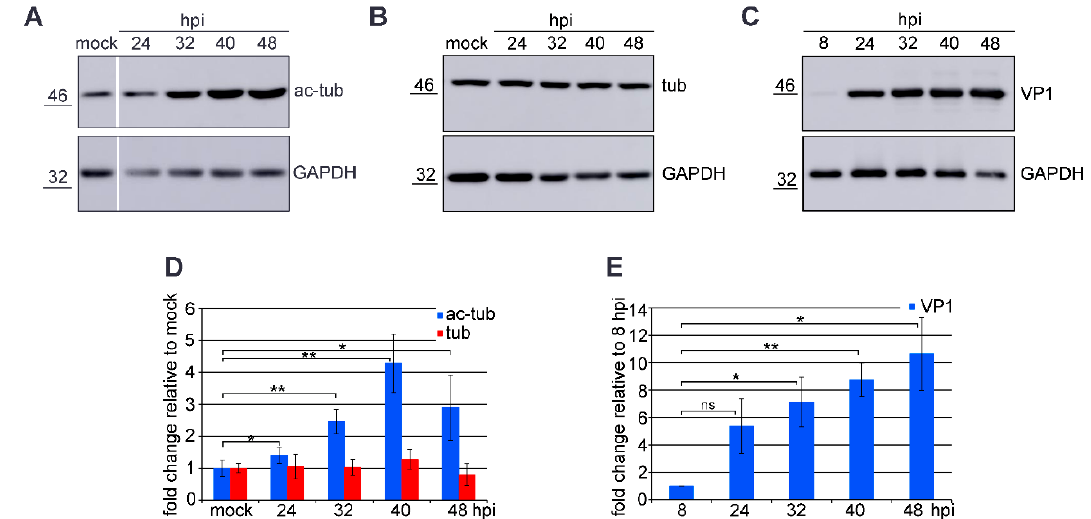
Figure 1. The acetylation of microtubules was elevated during the late phase of infection. ( A – C ) 3T6 cells were infected with MPyV and lysed at the indicated hours post infection (hpi). Lysates were separated by SDS / PAGE, transferred onto membrane, and acetylated tubulin (ac-tub), tubulin (tub), VP1, and GAPDH were stained by specific antibodies. ( D , E ) A graphic illustration of a densitometry analysis of the digital images of Western blots from four independent experiments. Shown is the fold increase relative to mock-infected cells (a representative 24 h time point) ( D ) or infected cells at 8 hpi (representing amount of incoming virus) ( E ). +/ − SD. * p < 0.05, ** p < 0.01, determined by the Student’s t test. The changes in total levels of tubulin ( D , red columns) were not significant (ns) according to the analysis using the Student’s t test.